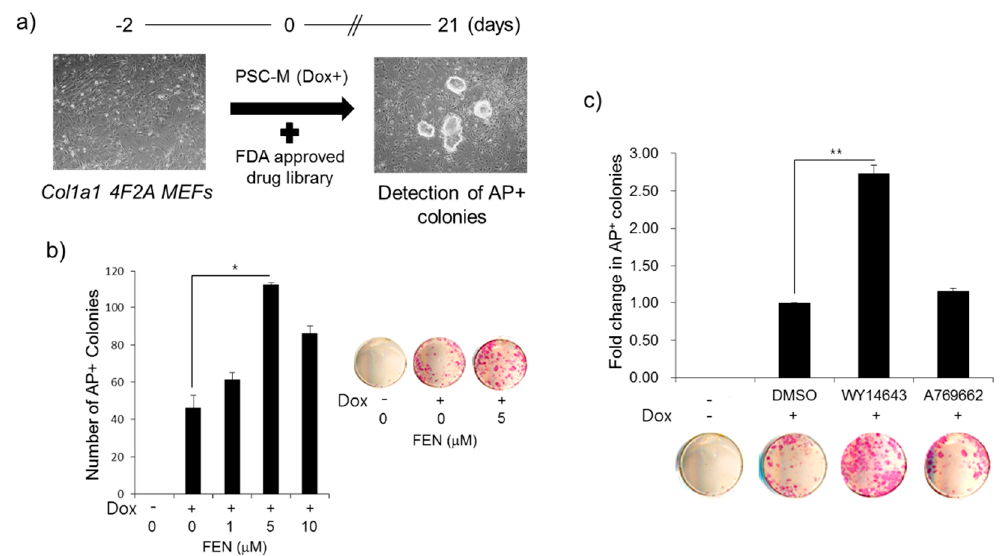
Figure 1. Screening and identification of PPAR α agonist fenofibrate (FEN) from selected